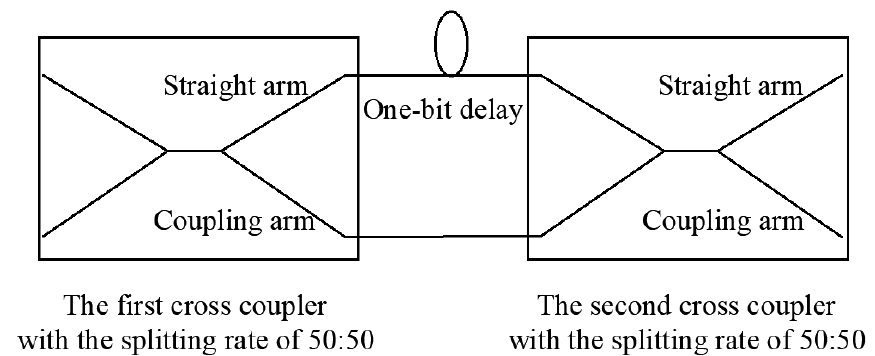
Figure 2. Schematic structure diagram of MZI. the structure of DPSK demodulation and phase detection. The difference is that the structure reduced the use of the front-end cross-coupler. Therefore, this design of the demodulator combines digital signal demodulation and phase difference detection. The structure diagram is shown in Figure